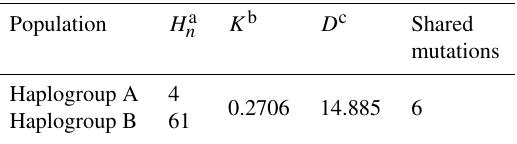
Table 4. Control region diversity between two mtDNA lineages. Population